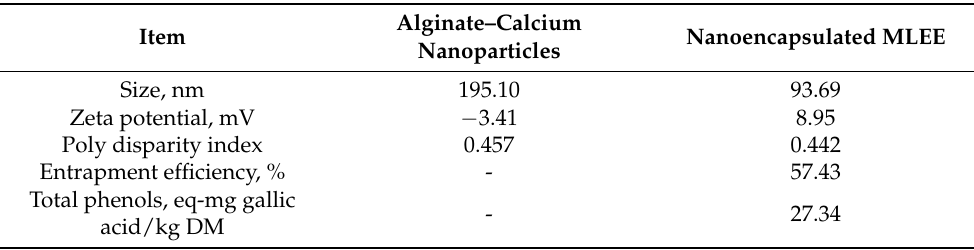
Table 3. Physicochemical characteristics of the alginate–calcium chloride nanoparticles and prepared